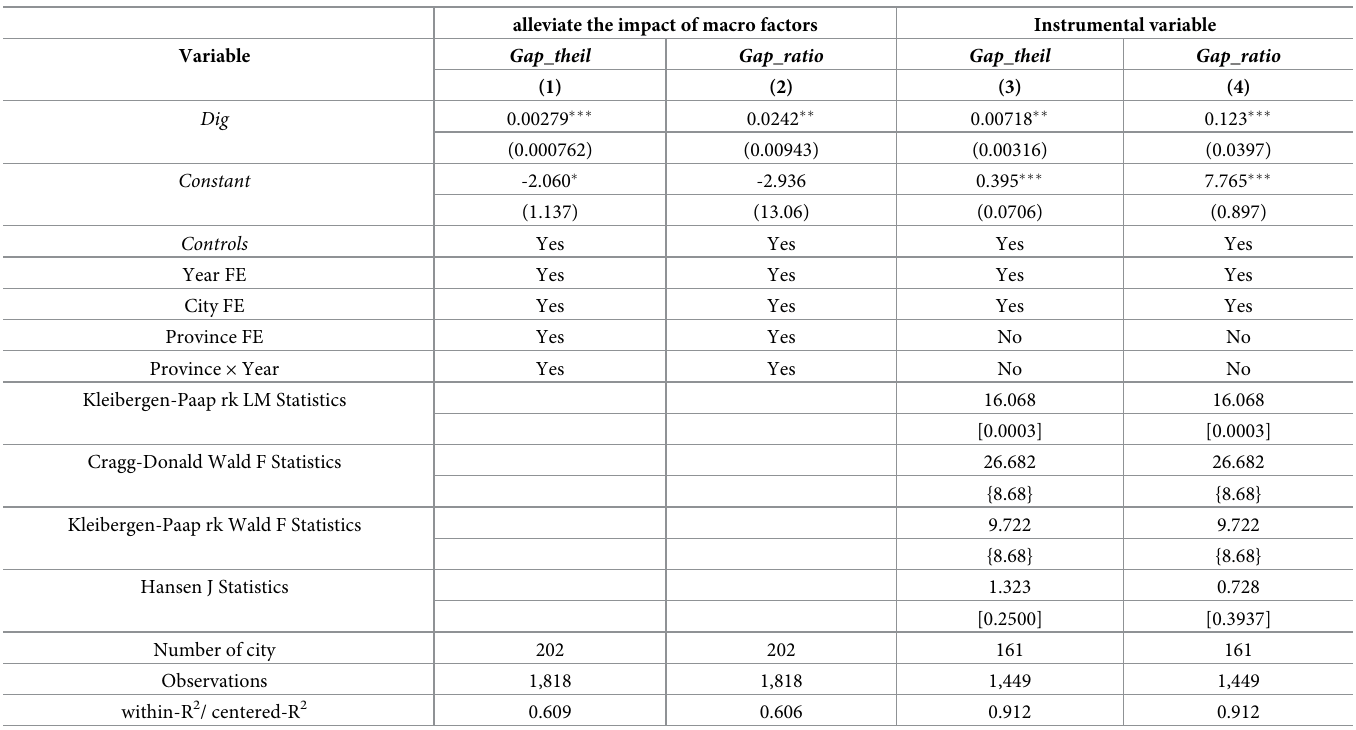
Table 9. Robustness